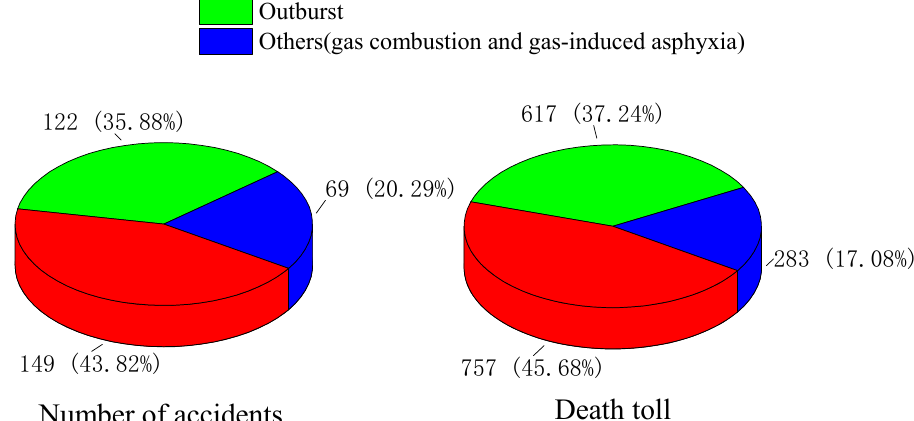
Figure 8. Proportion of various types of accidents in major gas accidents from 2008 to 2018. From 2008 to 2018, 52 gas explosion accidents occurred with 1181 deaths, accounting for 55.91% and 62.29% of the total number of tremendous and more severe gas accidents, respectively, and 34 coal and gas outburst accidents occurred with 605 deaths, accounting for 35.56% and 31.91% of the total number of tremendous and more severe gas accidents, respectively. Three gas asphyxia and poisoning accidents occurred with 51 deaths, accounting for 3.23% and 2.69% of the total number of tremendous and more severe gas accidents, respectively (Figure 9).